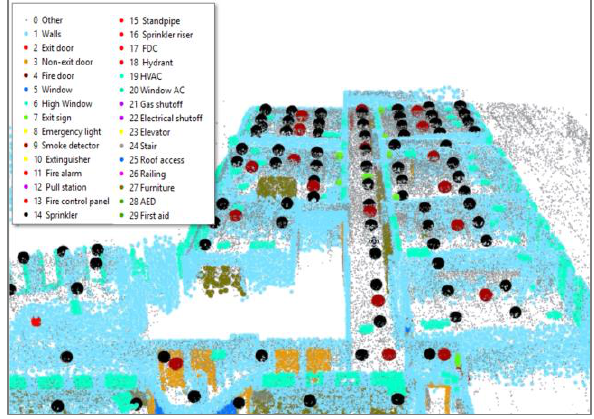
Figure 5 : Example of classified point